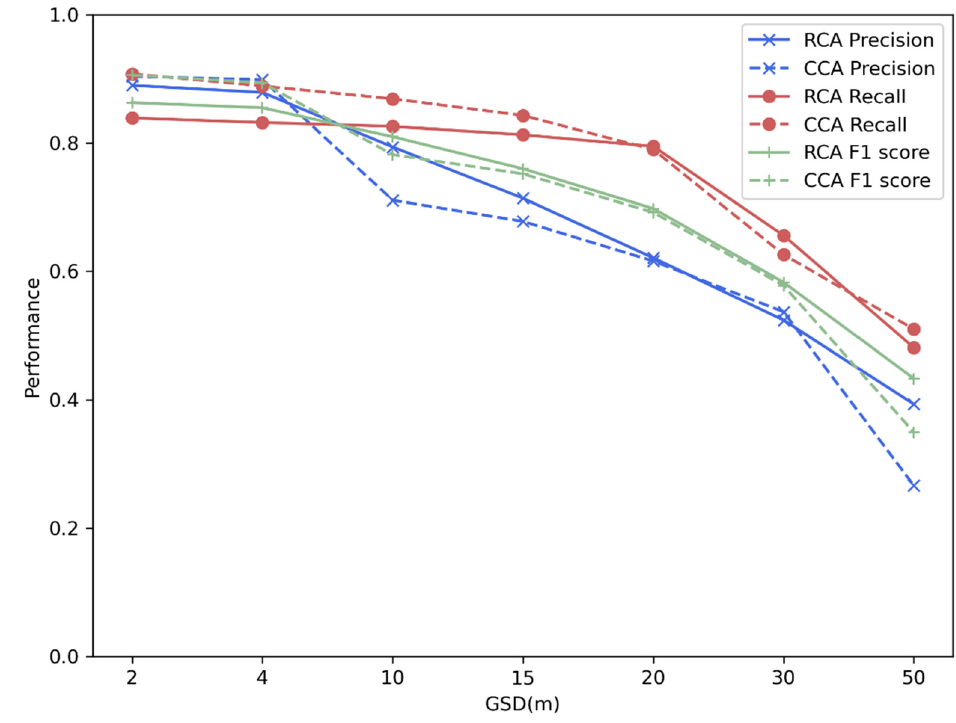
Figure 4. Precision, recall, and F1 score of test samples with different spatial resolutions in two types of aquaculture area.